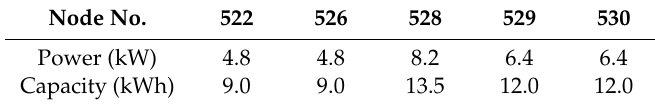
Table 2. The result of selecting the location and parameters of ESU for the analyzed LV grid (load profile A). Node